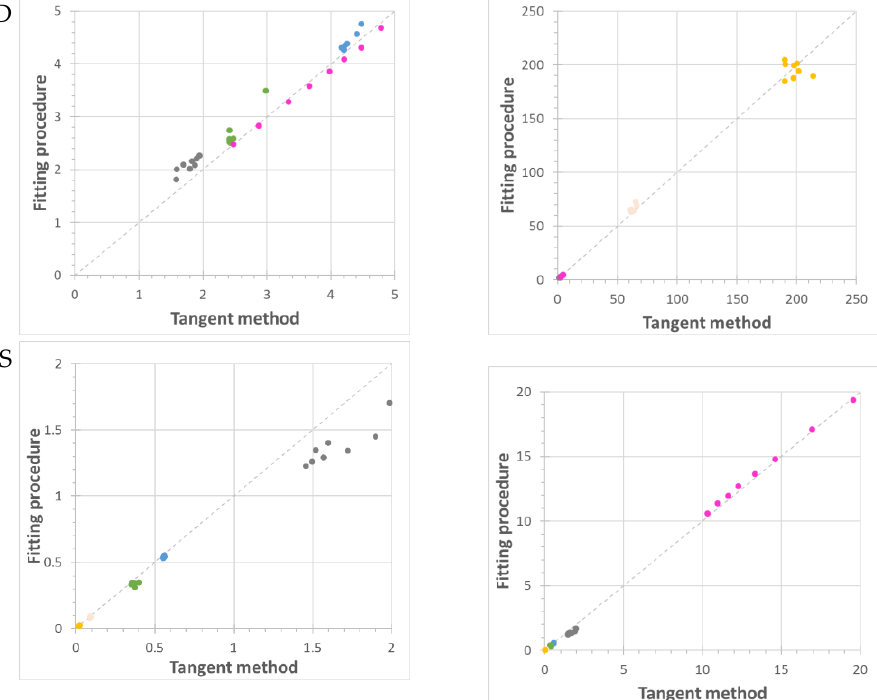
Figure A1. Plot of the permeability [Barrer], time lag [s], diffusivity [10 − 12 m 2 s − 1 ] and solubility [cm 3STP cm ‐ 3 bar − 1 ] ‐ determined by the fitting procedure plotted vs. the values obtained via the tangent method for the following gases: CO 2 ( ), N 2 ( ), O 2 ( ), CH 4 ( ), H 2 ( ), He ( ).